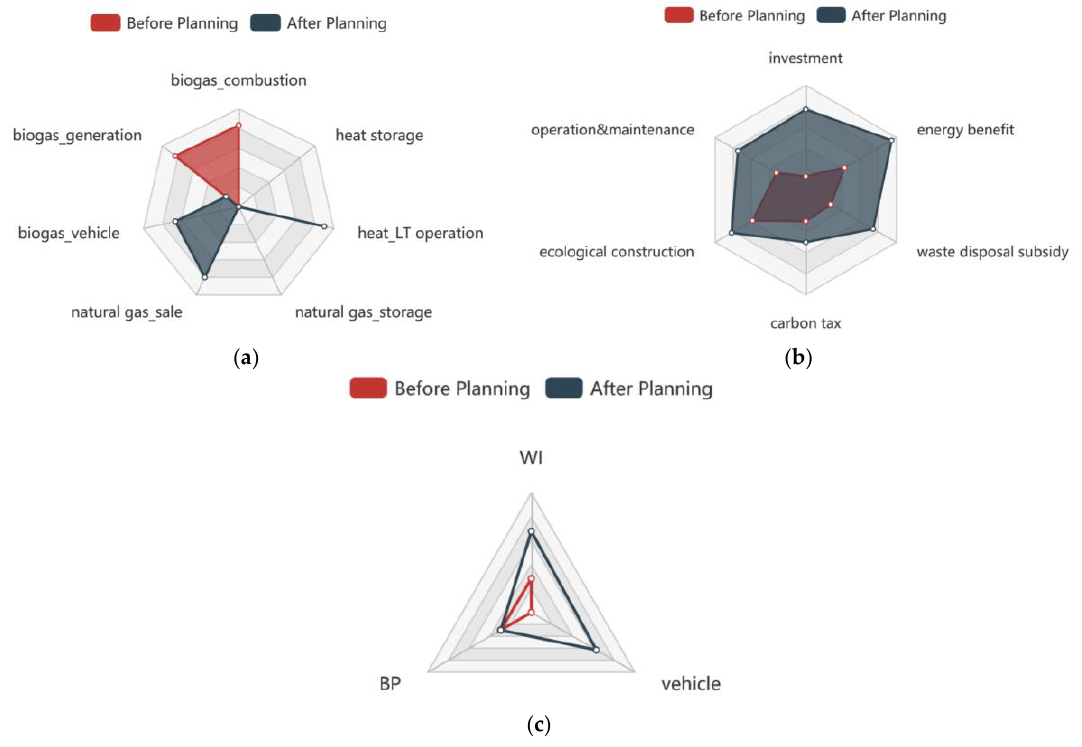
Figure 8. Benefit comparison in WPB before and after planning. ( a ) Energy utilization ration; ( b ) Expenditure and income; ( c ) Carbon emission reductions.